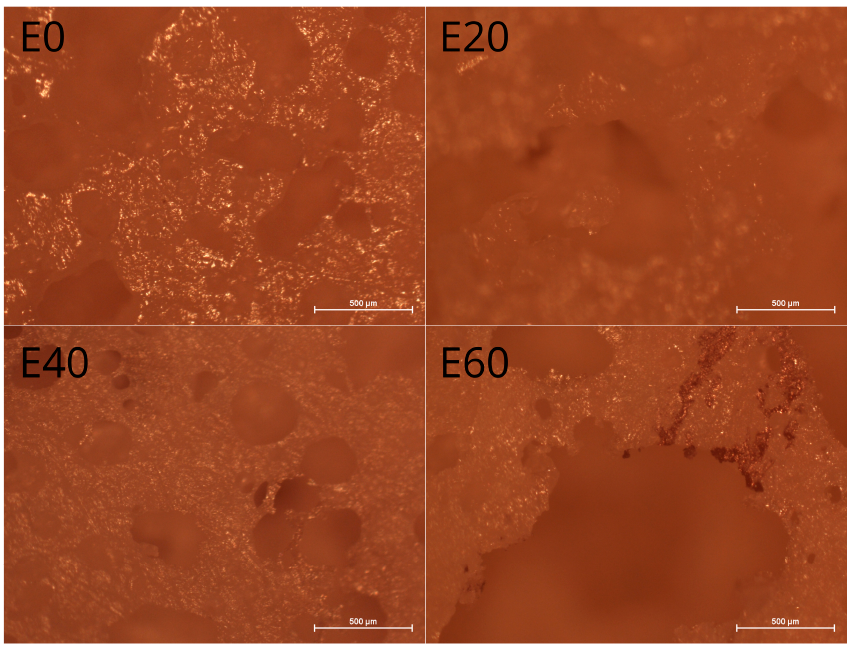
Figure 3. The optical microscope images (magni fi cation 40×) for the obtained macarons.